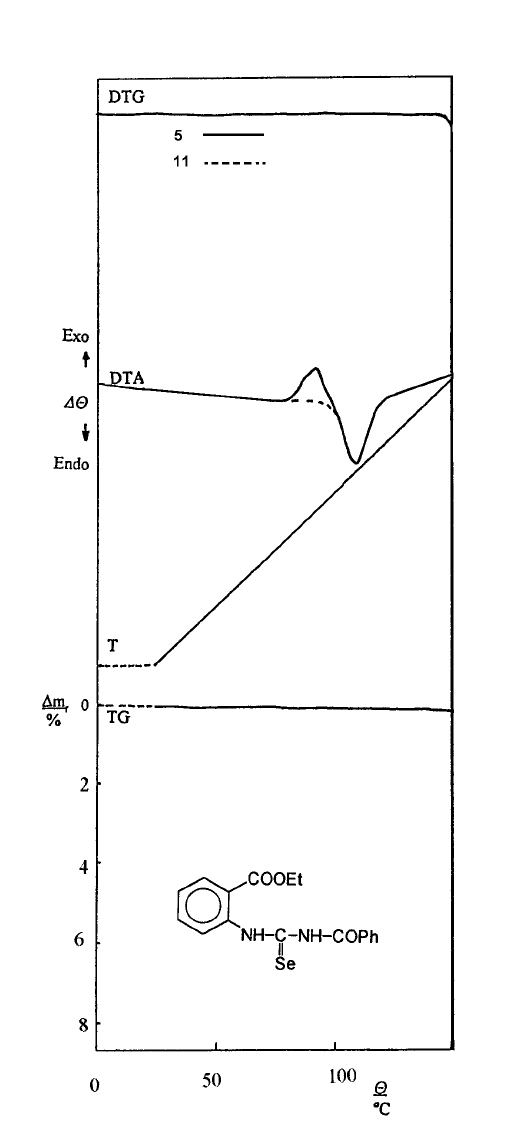
Figure 6. The record of thermal analysis of 5 and 11